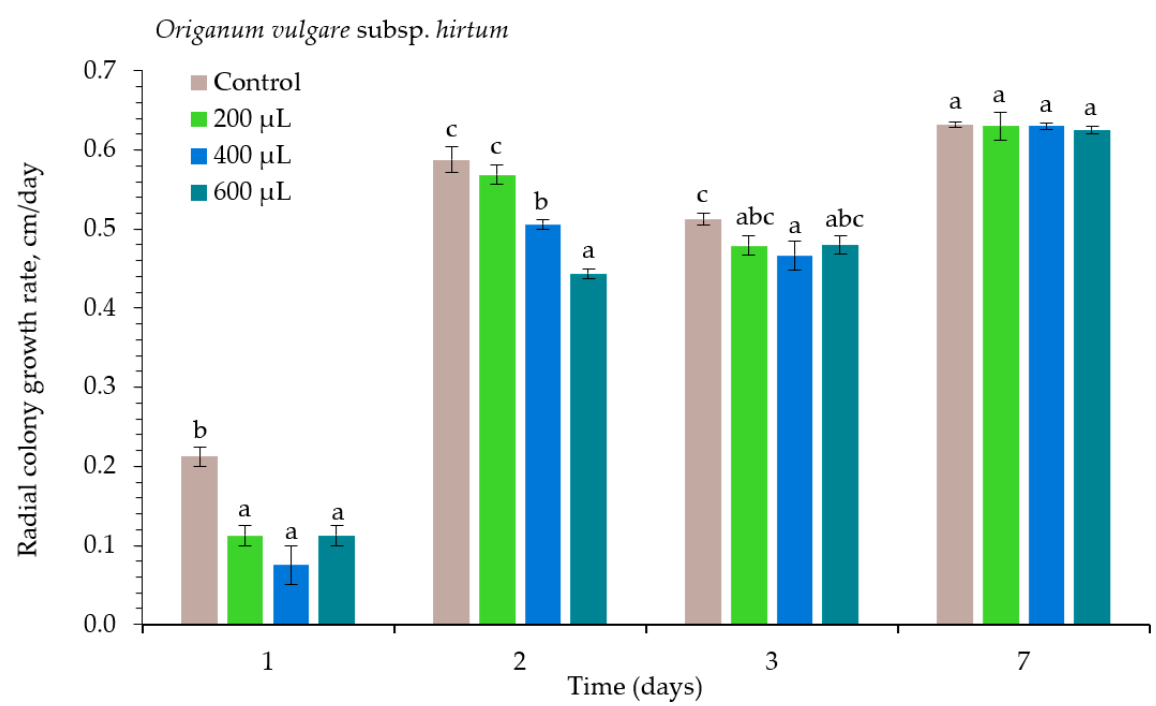
Figure 1. The radial colony growth rate of Alternaria spp. under the influence of Origanum vulgare subsp. hirtum essential oil. The same letter indicates no significant differences between treatments ( p < 0.05).